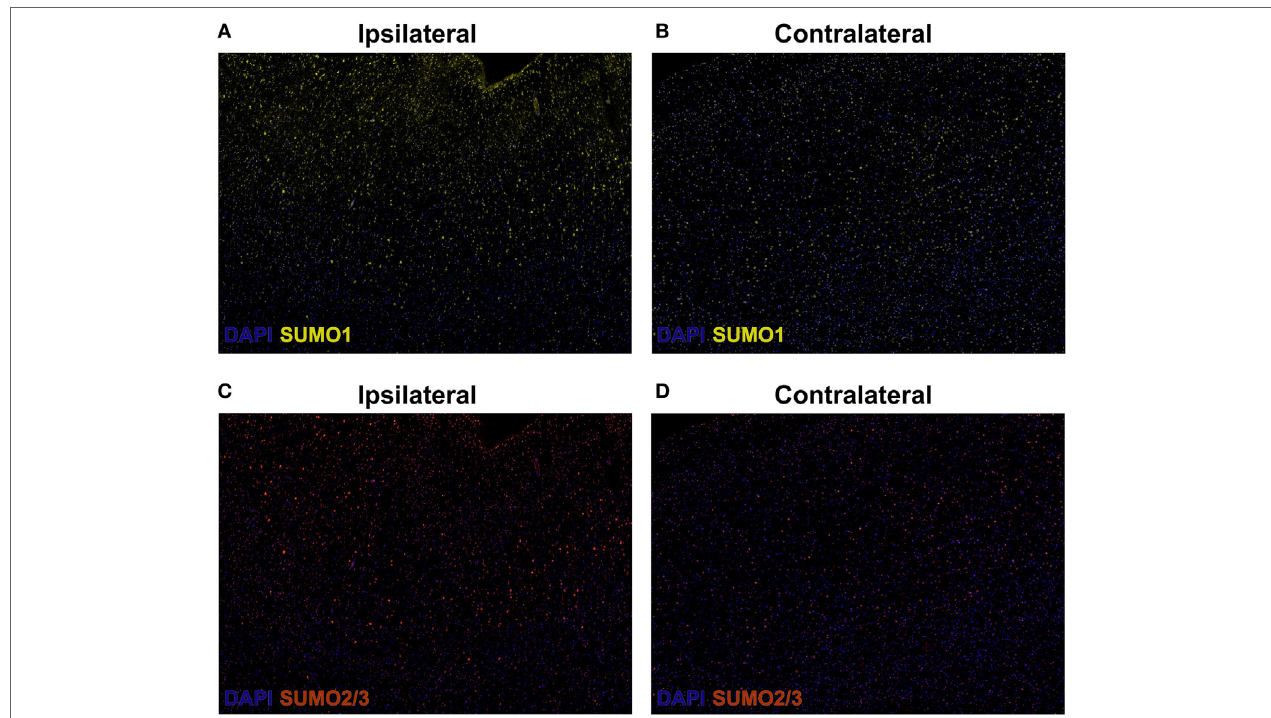
FIGURe 2 | Composite wide-field fluorescent multiplex immunohistochemistry (mIHC) images (yellow, SUMO1; red, SUMO2/3; blue, DAPI,). (a) Ipsilateral, SUMO1. (B) Contralateral, SUMO1. (C) Ipsilateral, SUMO2/3. (D) Contralateral, SUMO2/3. Capture parameters of ipsilateral and contralateral images were identical. Cropped ROIs were taken from comparable layers of cortex. The intensity of SUMO1 and SUMO2/3 immunoreactivity is increased in neurons residing within the penumbral tissue compared to neurons in the matched contralateral